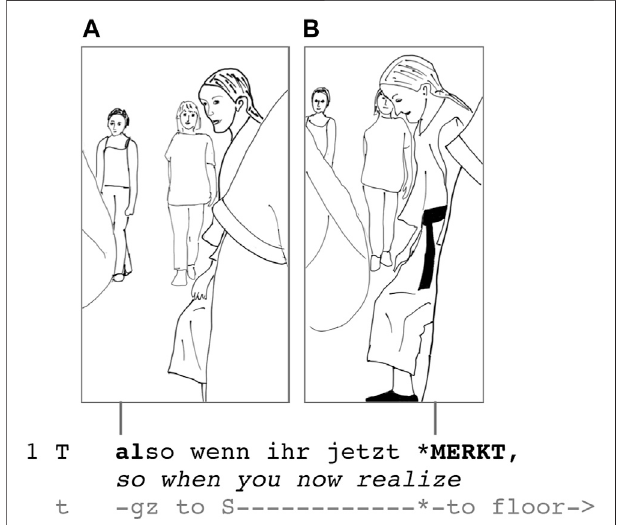
FIGURE 1 | Speaker gaze shift from addressees to focal